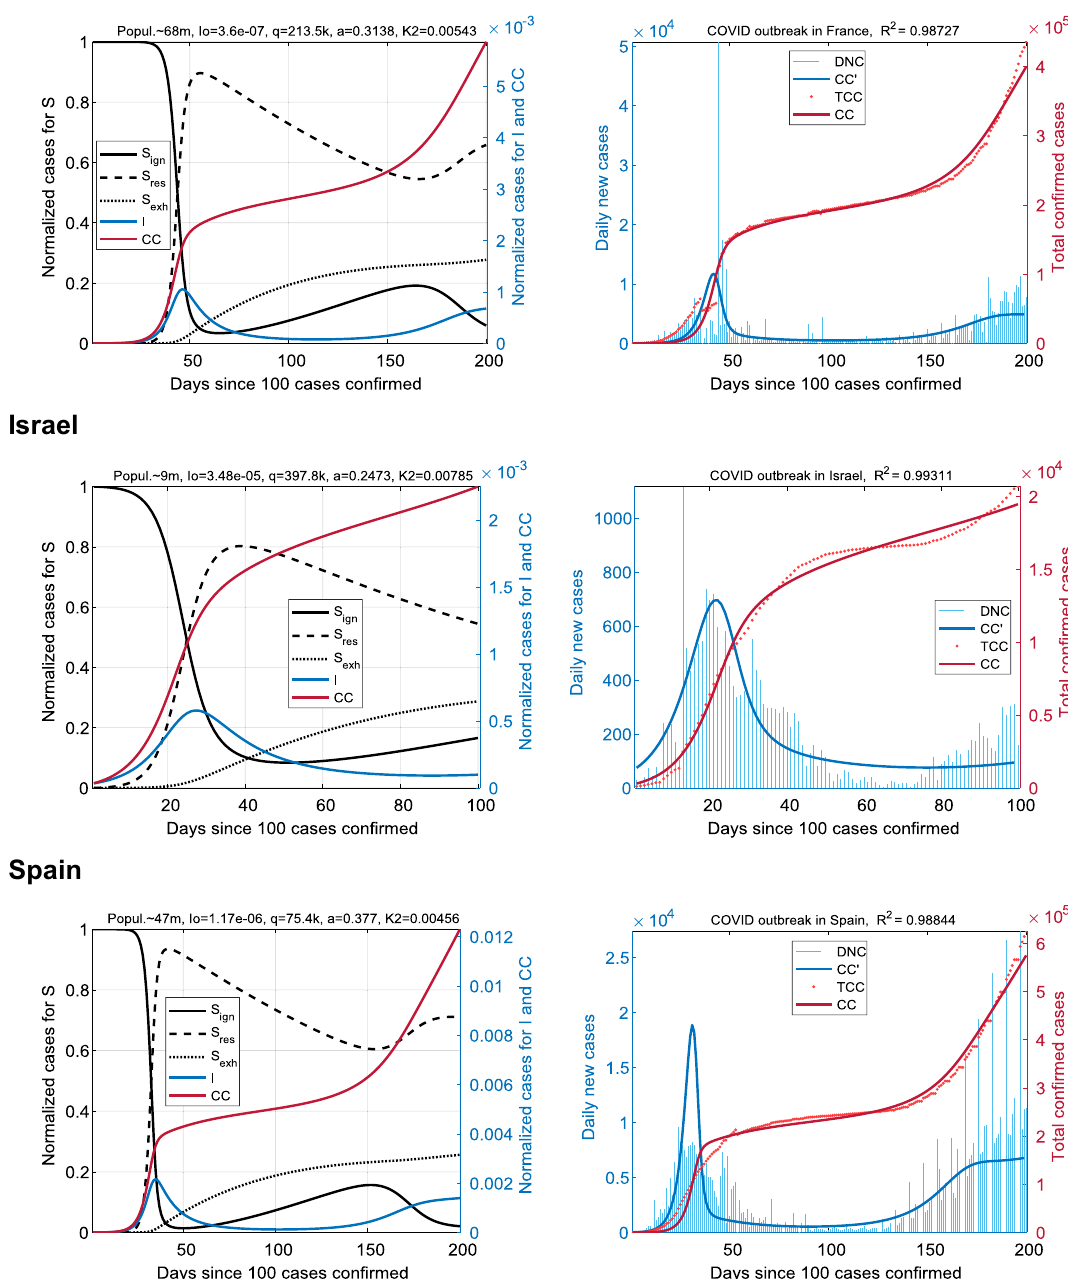
Figure 3. Coronavirus outbreaks in countries with a high resistance index. Results for France (top panel), Israel (center), and Spain (bottom). The outbreaks dynamics are characterized by a rapid increase in the S res fraction during the peak of the first wave and the formation of protracted plateau on CC(t) with low DNC indices. To simulate the spread of COVID in Israel (population is less than 10 million), we take an interval of 100 days. Numerous data corrections in France and Spain for the period April’20–May’20 lead to the minor (practically negligible) discrepancies between the CC and TCC 32% of the population at parameters (0.12, 0.1) and 80% of the population at (0.2, 0.1). Observations of COVID- 19 epidemics show that the first wave of the disease does not reach such high values and stops much earlier. Countries with a high resistance index. Next, we analyzed the infection data of COVID-19 for coun- tries where the coronavirus outbreak evolved dramatically like in China: it was relatively short-lived, and after it, the morbidity rate DNC(t) rapidly dropped to a low level. For this purpose data about France, Israel, and Spain were selected and analyzed (Fig. 3). Several trends were revealed from the results in Table 1. The parameter q ,